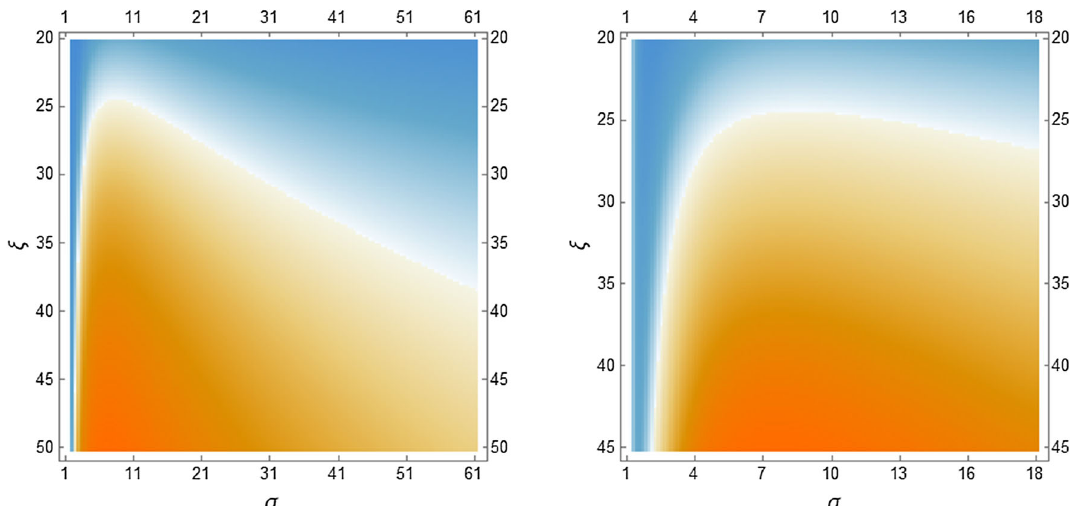
Fig. 12 Plot of the location of the maximum of the relative change of the absolute value of velocity δ αα (cid:2) (ξ) . Warmer tones correspond to its positive values and colder tones to the negative ones. White color